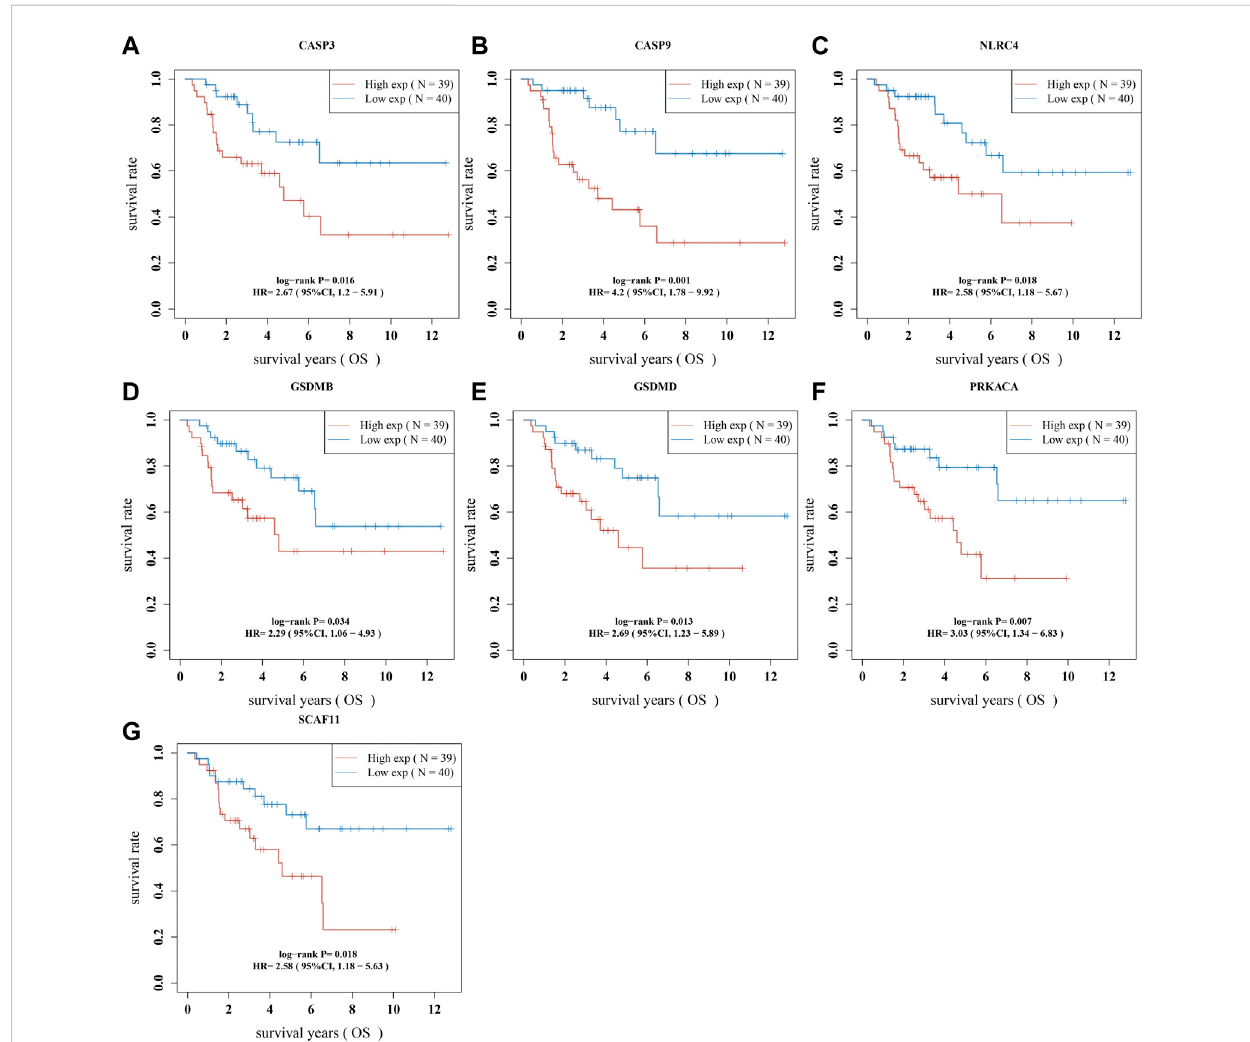
FIGURE 4 The prognostic value of PRGs in ACC. The Kaplan – Meier survival curves of (A) CASP3, (B) CASP9, (C) NLRC4, (D) GSDMB, (E) GSDMD, (F) PRKACA, and (G) SCAF11 in ACC patients in the high-/low-expression group.